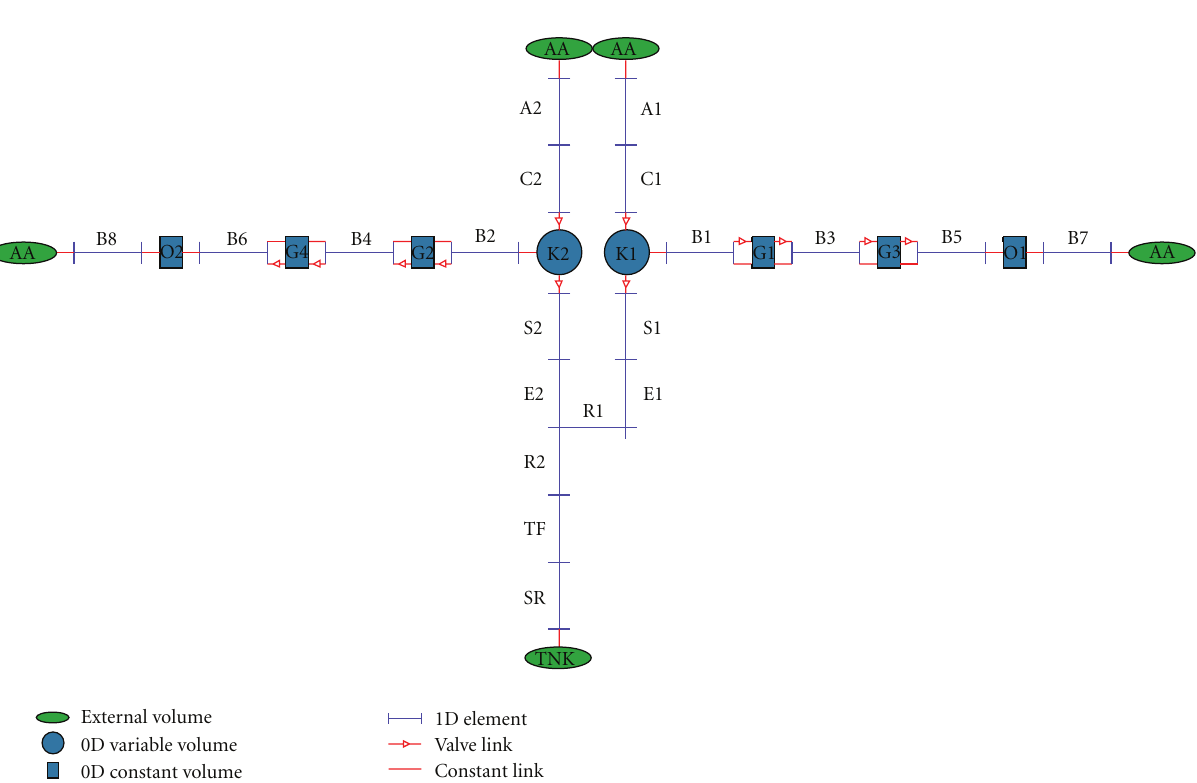
Figure 14: Final 0D-1D scheme for the compressor with blow-by